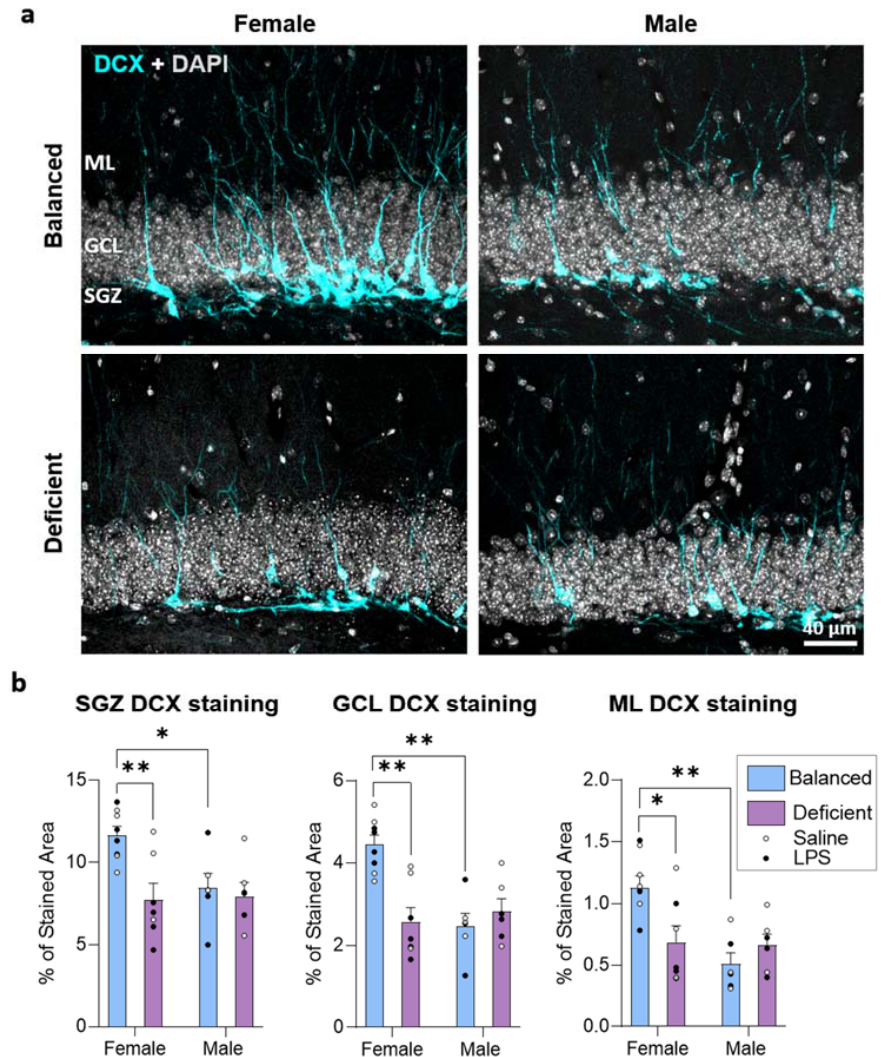
Figure 5. The n ‐ 3 PUFA ‐ deficient diet reduced the proportion of area occupied by doublecortin (DCX) staining in the dentate gyrus of female mice. ( a ) Confocal images (sum of intensities projection, z = 13.8 μ m) of the dentate gyrus (DG) of the hippocampus showing DCX (cyan) staining in the subgranular zone (SGZ), the granule cell layer (GCL), and the molecular layer (ML). ( b ) Female mice fed with the n ‐ 3 PUFA balanced diet showed a higher percentage of area stained for DCX than males fed with the same diet. The n ‐ 3 PUFA ‐ deficient diet reduced the DCX staining exclusively in female mice (interaction between diet and sex detected, no effect of LPS detected). * p < 0.05, ** p < 0.01 (statistics detailed in Supplementary Data).